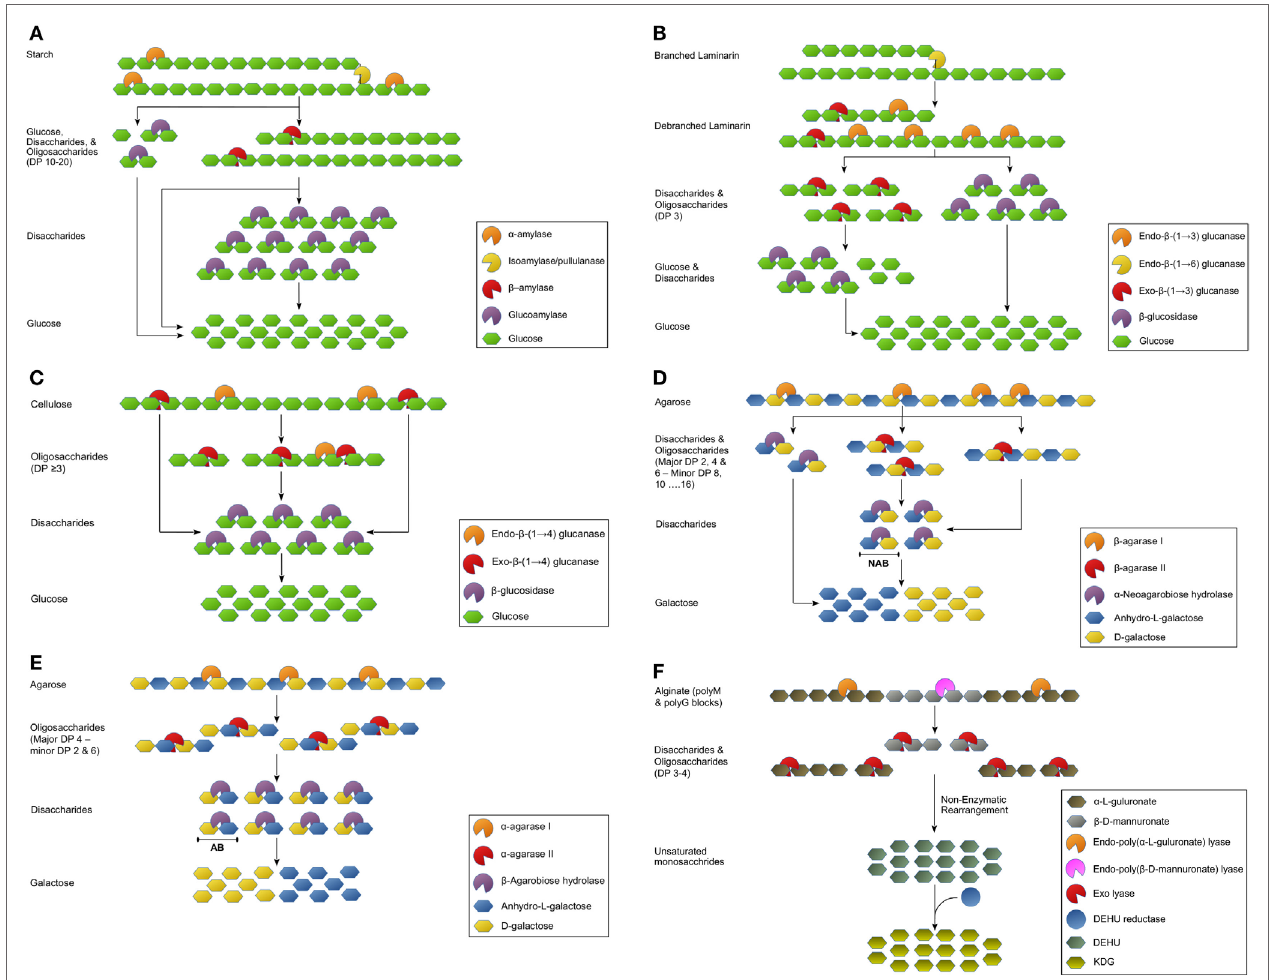
FiGURe 2 | Schematic diagrams for the enzymatic hydrolysis of algal polysaccharides . (A) Starch, floridean starch, and glycogen, (B) laminarin, chrysolaminarin, and paramylon, (C) cellulose, (D) agarose by β -agarases, (e) agarose by α -agarases, and (F) alginate. DP, degree of polymerization; NAB, neoagarobiose; AB, agarobiose; DEHU, 4-deoxy- l -erythro-5-hexoseulose uronic acid; KDG, 2-keto-3-deoxy-gluconate; M, β - d -mannuronate; G, α - l